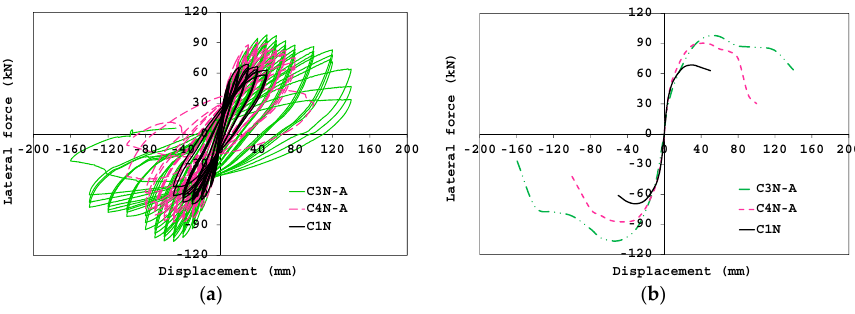
Figure 8. F ‒Δ hysteresis curves ( a ) and envelopes ( b ): columns C1N, C3N-A and C4N-A.